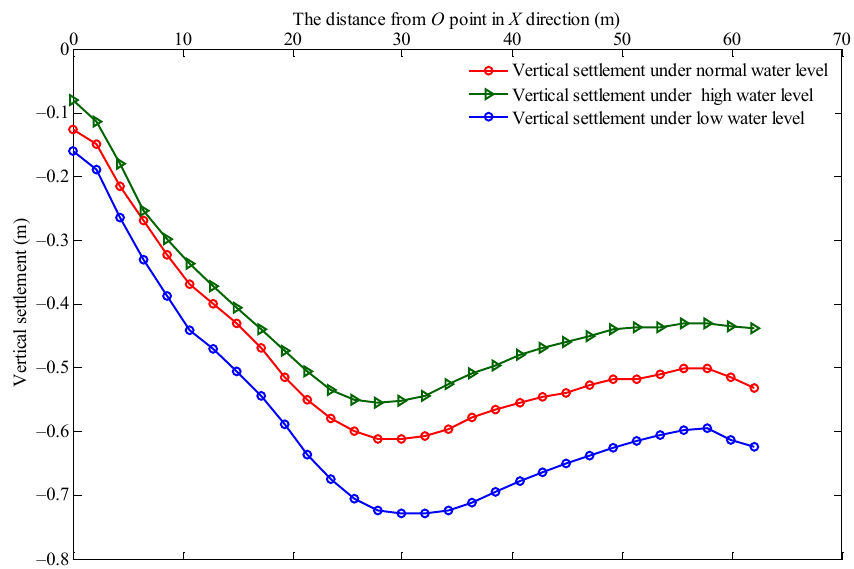
Figure 10. Vertical settlement of the top surface of the riverbank slope in the horizontal direction under different water levels.